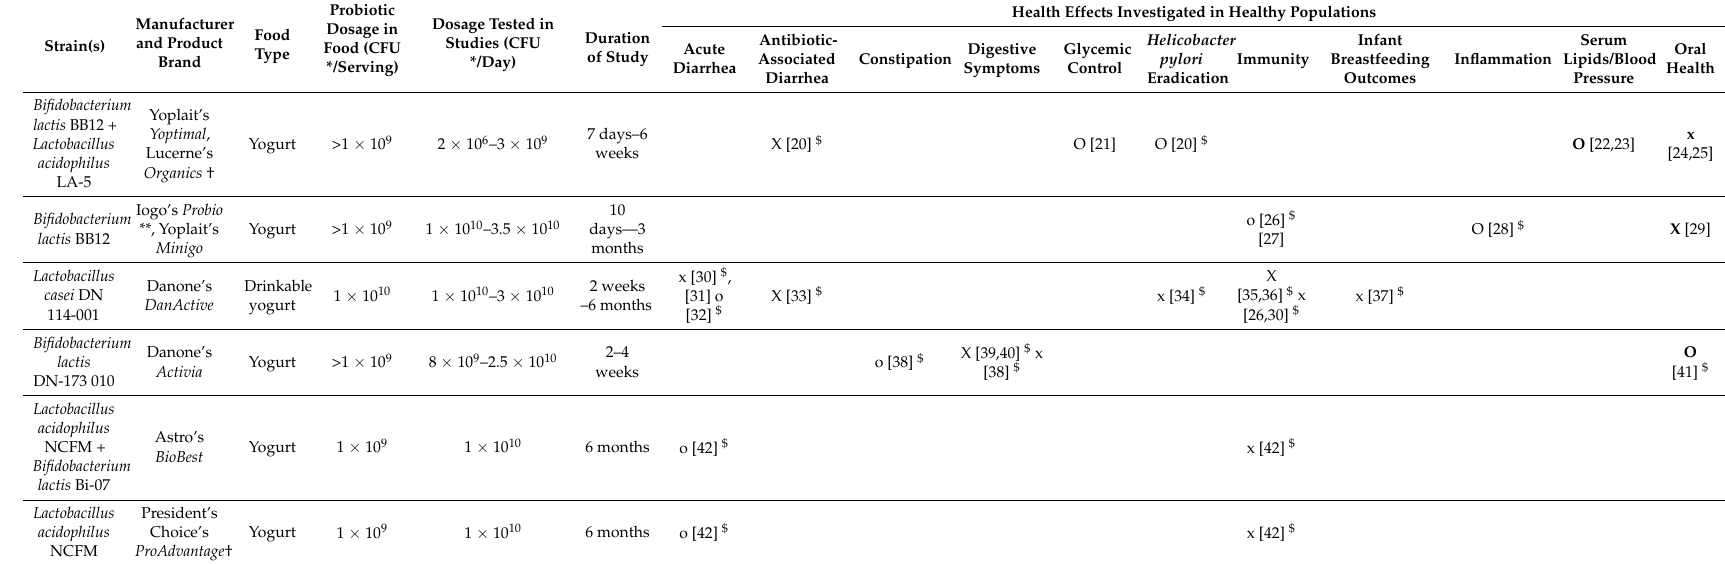
Table 1. Strains in probiotic food products and reported health effects associated with these